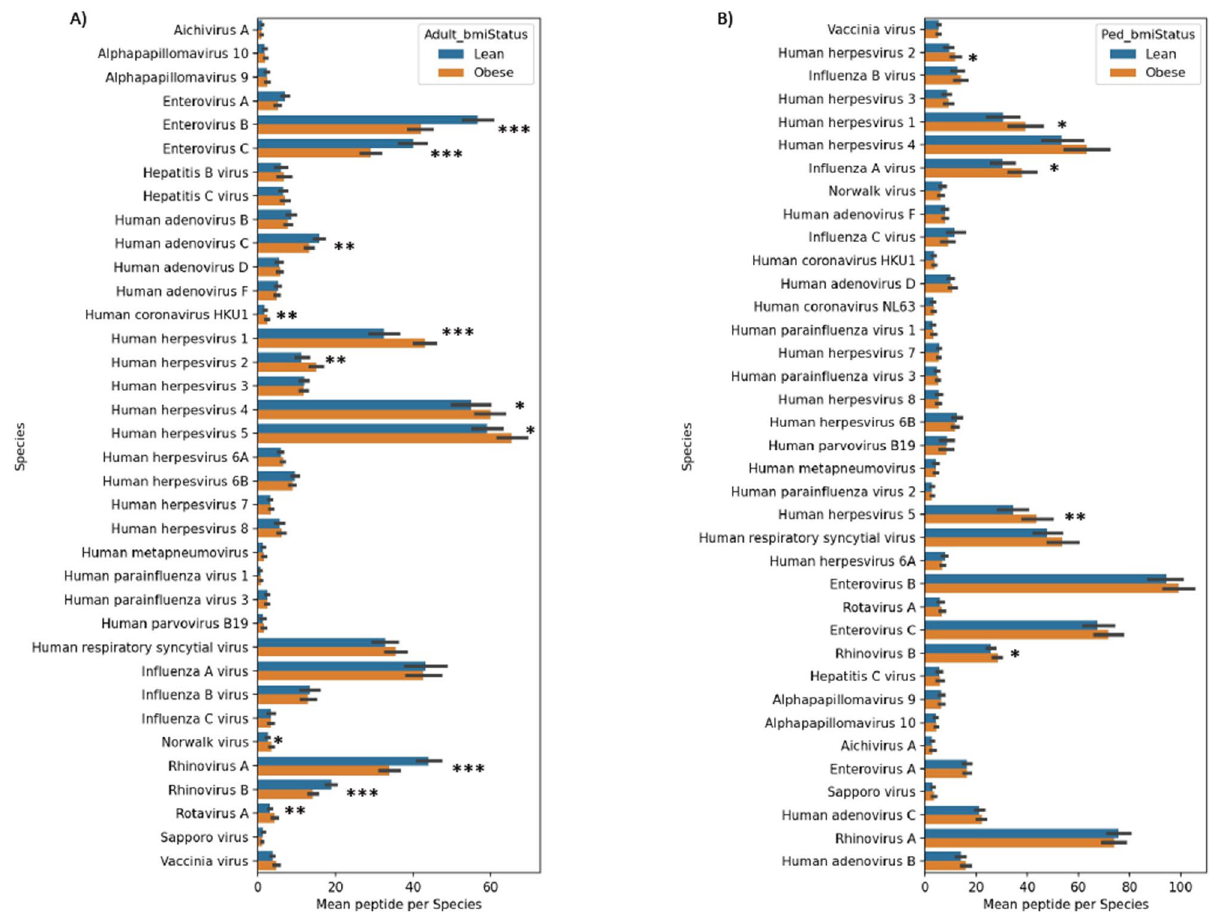
Figure 1. Antibody responses to viral peptides in obese versus lean populations. Peptides that were immunoprecipitated by antibodies present in the serums specimens and passed the significance and reproducibility thresholds for enrichment were counted per virus per specimen. Bar plots showing standard error mean (SEM) of the enriched peptide number for the most prevalent viruses (> 10%) between the lean and obese groups of the adult ( A ) and pediatric ( B ) cohort. * p < 0.05, ** p < 0.01, *** p < 0.001 by Mann Whitney’s U